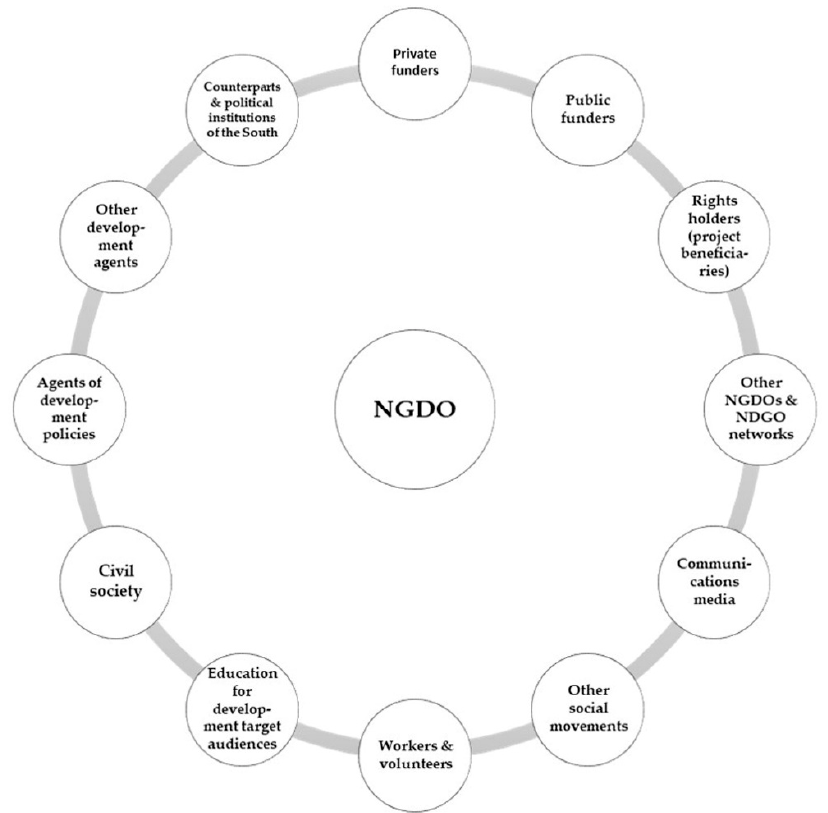
Figure 3. Stakeholders in the environment of NGDOs. Source: The authors.